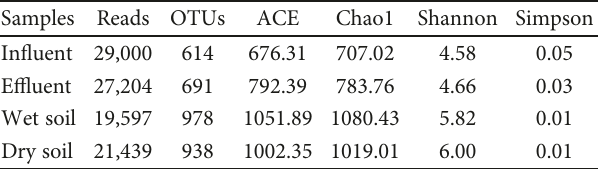
Table 2: Bacterial alpha diversity indices of four samples. Samples Reads OTUs ACE